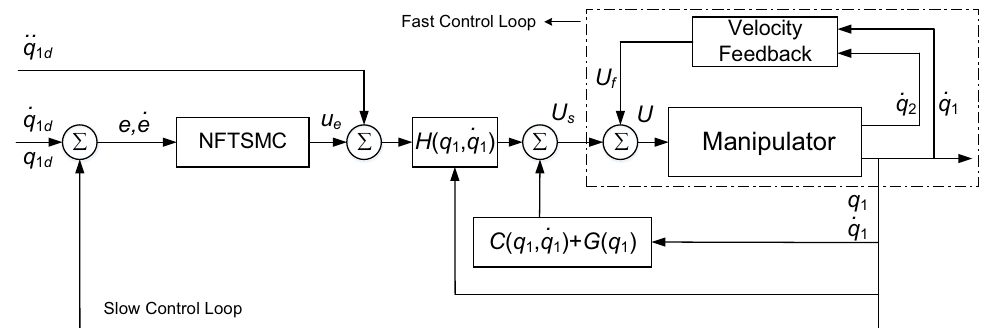
Figure 6. The loop of the proposed control